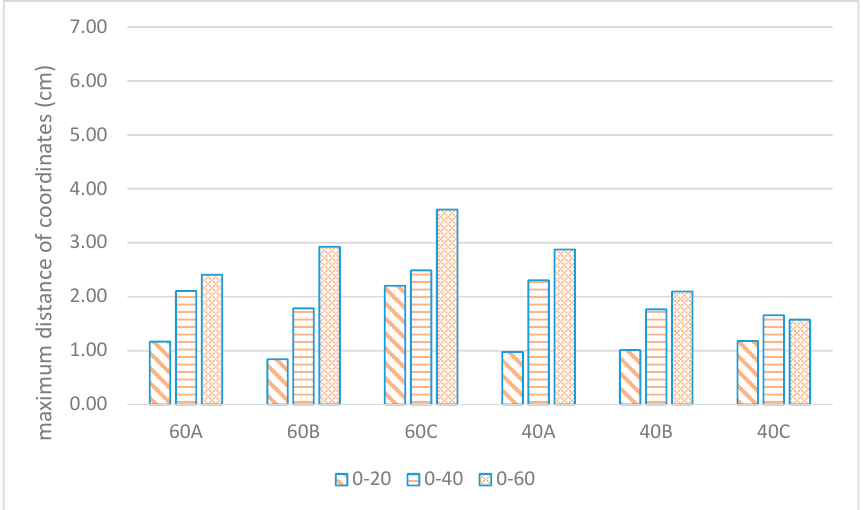
Figure 7. Acoustic emission source location (AESL) for Specimen 1 WC60 Design C.